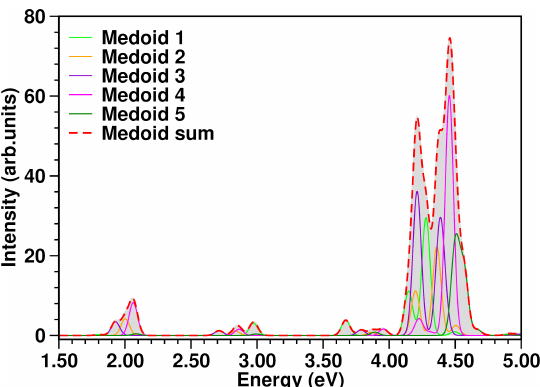
Figure 5. TCNE: π :1ClN absorption spectrum (in eV) calculated at TD-CAM-B3LYP/6-31G(d,p)/ GD3/C-PCM(DCM) level of theory from each medoid and as the sum spectrum of the structures representative of the conformational equilibrium in the ground state. The color code is presented in the graph legend. The sum spectrum (red dashed curve) was obtained as the sum of individual medoid contributions (presented in the figure as well, see color legend), each one already multiplied by the k-th cluster population. See Equation (5) and the procedure explained in Section 3.4 for more details.